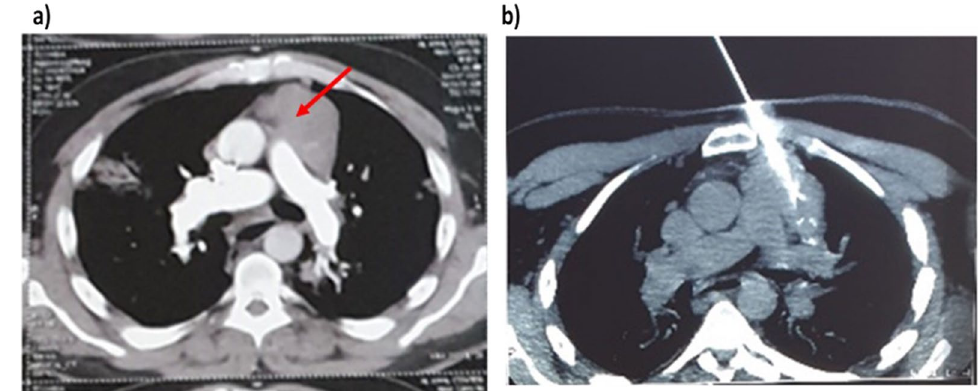
Fig. 1 a Red arrow in the axial view of the chest’s computed tomography showing thymoma. b True cut needle